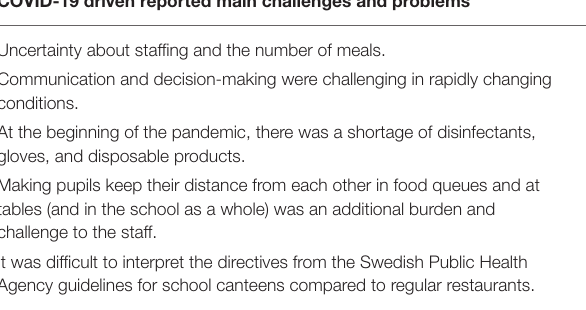
TABLE 7 | Challenges and positive developments during COVID-19 in Sweden. COVID-19 driven reported main challenges and problems Uncertainty about staffing and the number of